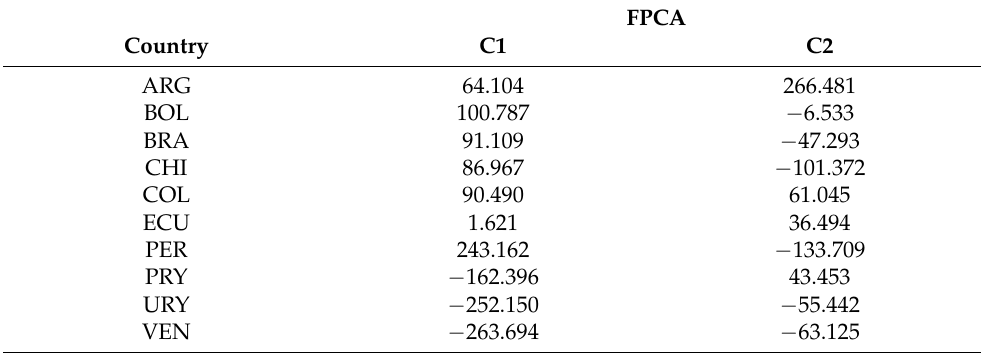
Table 8. Loading matrix for data on the number of COVID-19 deaths with two components (C1 and C2) for the indicated country using the FPCA.